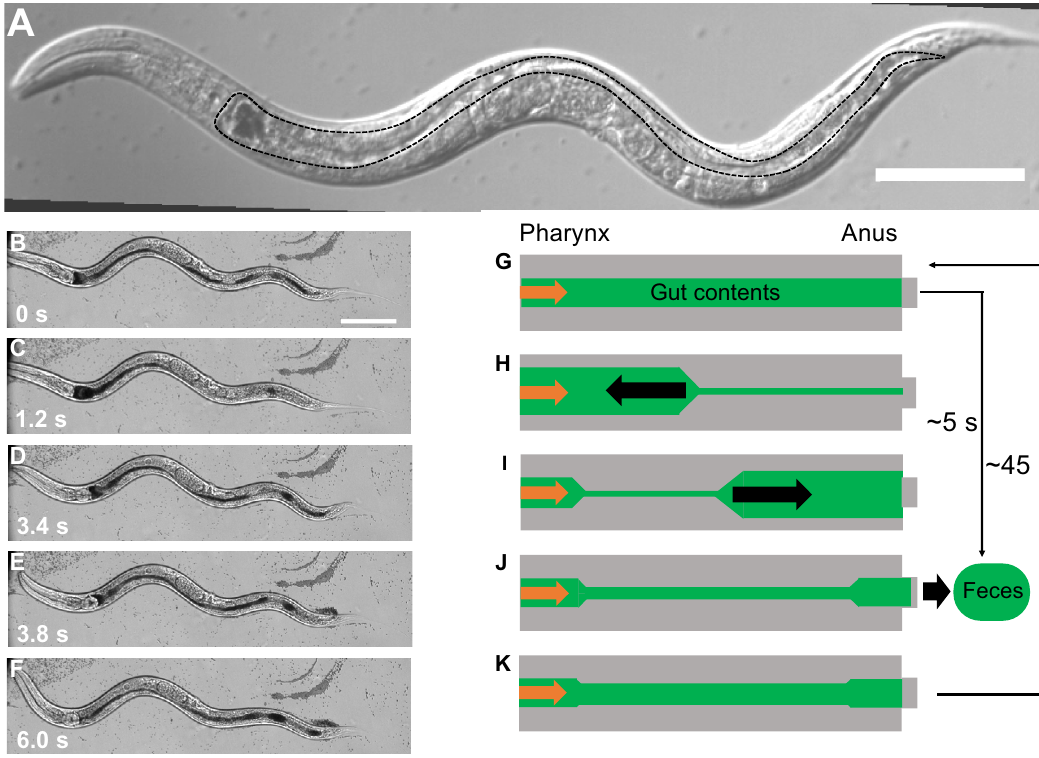
Figure 1. Body structures and intestinal functions of C. elegans . ( A ) DIC image of the body of C. elegans . The green area surrounded by a dotted line is the intestine. ( B-F ) DIC images of defecation. Black objects are particles stored in the intestine. Time is shown at lower left. (G-K ) Defecation behavior of C. elegans . ( G ) The gut contents are distributed evenly before defecation; food materials are provided from the pharynx. Orange arrow indicates inlet from the pharynx. ( H ) When defecation begins, the gut contents flow toward the pharynx and accumulate in the anterior intestine. ( I ) Gut contents flow toward the anus and accumulate in the posterior intestine. ( J ) A portion of the gut contents is expelled through the anus. ( K ) Inlet from the pharynx and flow caused by body bending confer an even gut-content distribution, as shown in ( G ). Scale bars, 100 µm for ( A ) and ( B